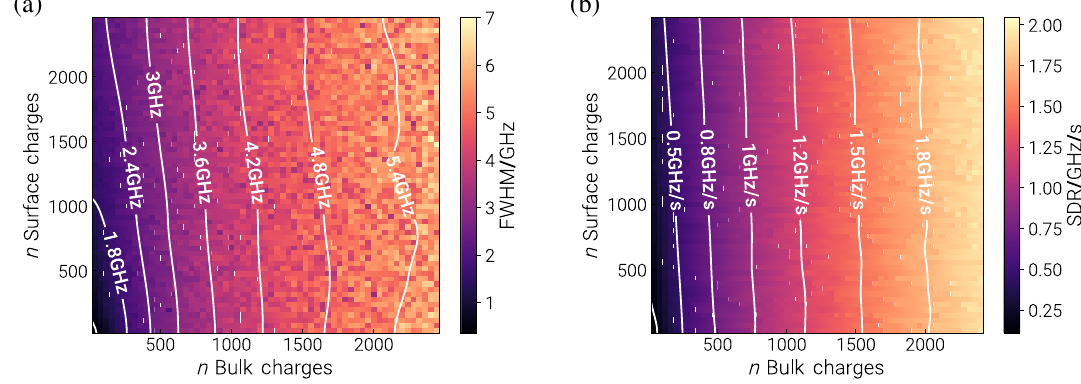
FIG. 12. Joint effect of surface and bulk charges. (a) Inhomogeneous broadening for a range of surface and bulk charges. (b) SDR calculated by fixing the time step per reordered charge configuration at 2000 bulk charges, which corresponds to a broadening of approximately 5 GHz (without